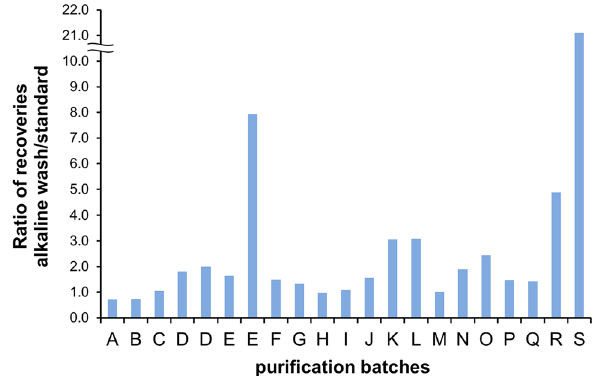
Figure 2. Ratio of recovery during protein A purification. 21 medium batches (19 IgGs) were purified by alkaline wash method and standard method.